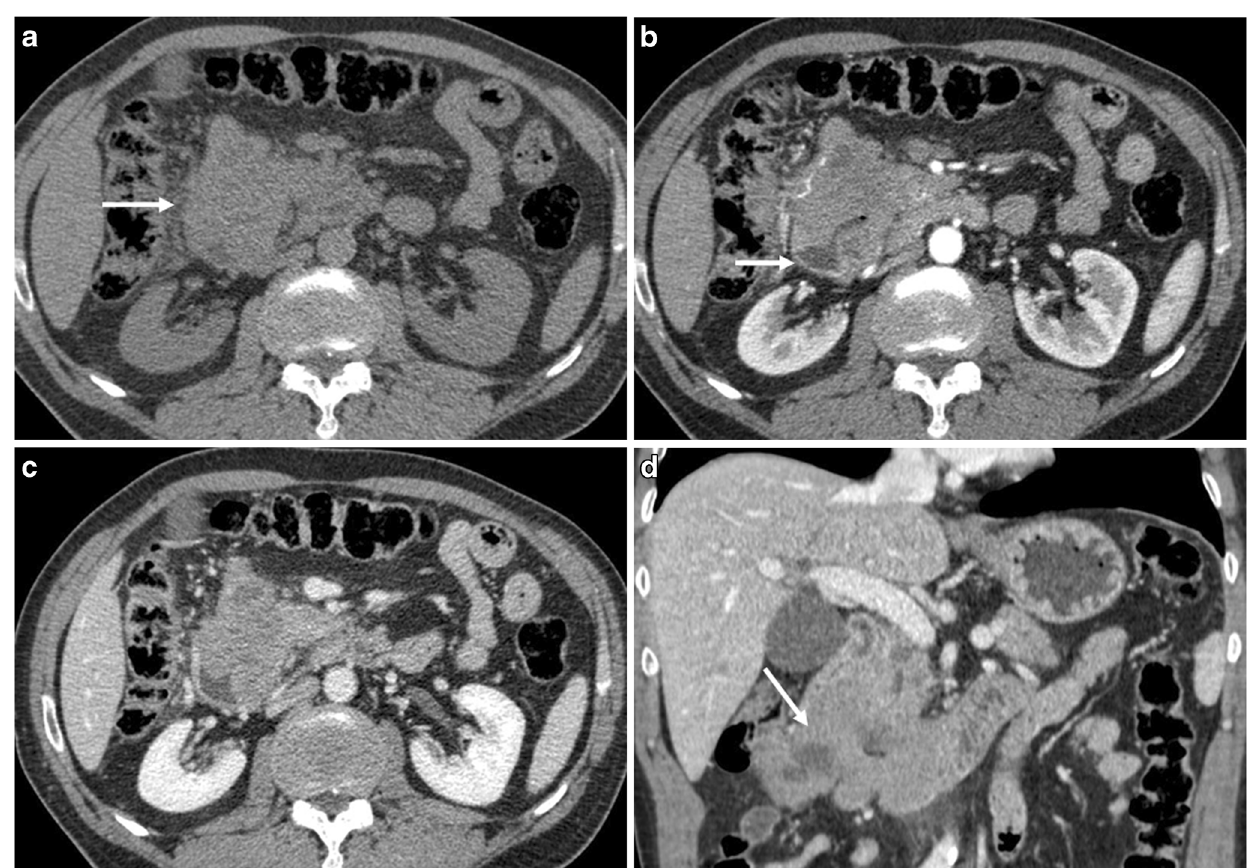
venous phase ( b, c ): the neoplasm protrudes in the duodenum (arrow), as better demonstrated on coronal reconstruction ( d ). The histopatholog- ical diagnosis was reached with endoscopic biopsy of the involved duo- denal